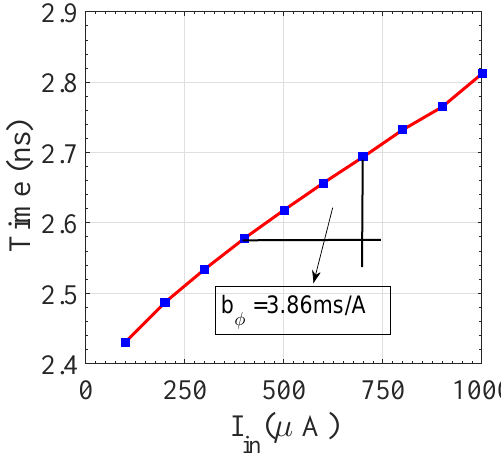
Figure 5. Characteristics of the proposed CTC.